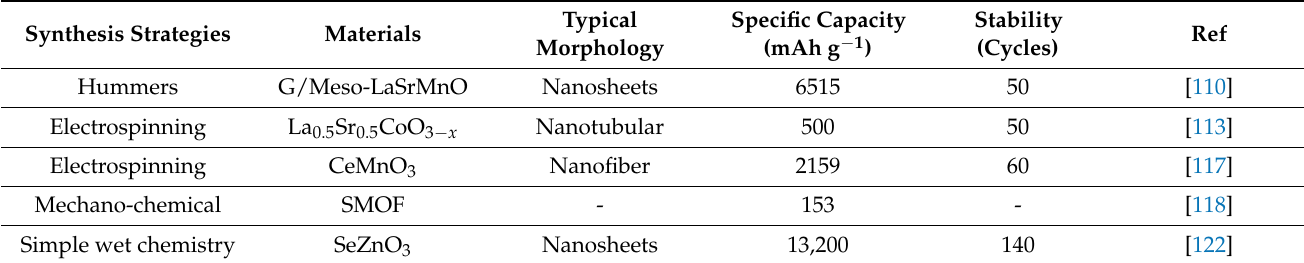
Table 4. Performance comparison of specific capacities with different electrode